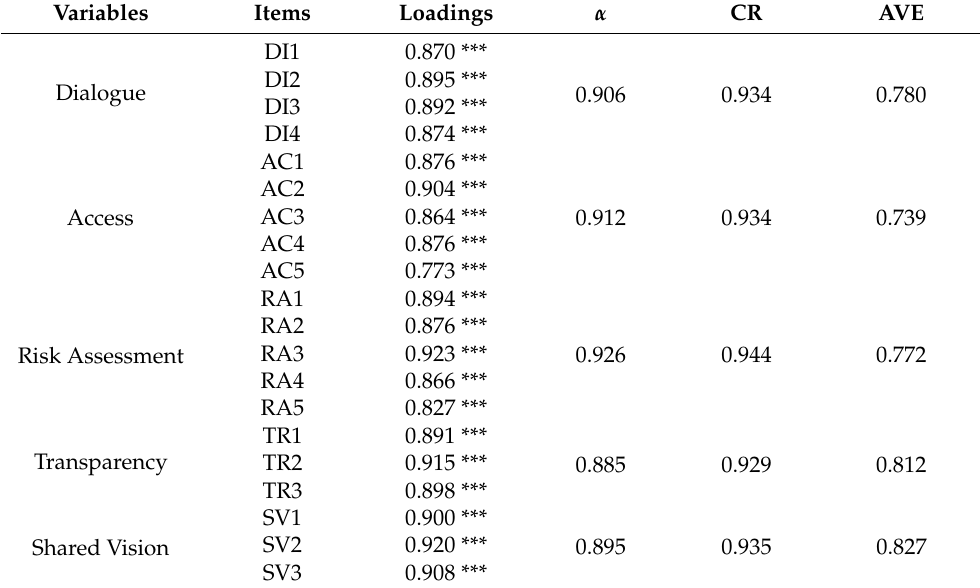
Table 2. Outer model results.